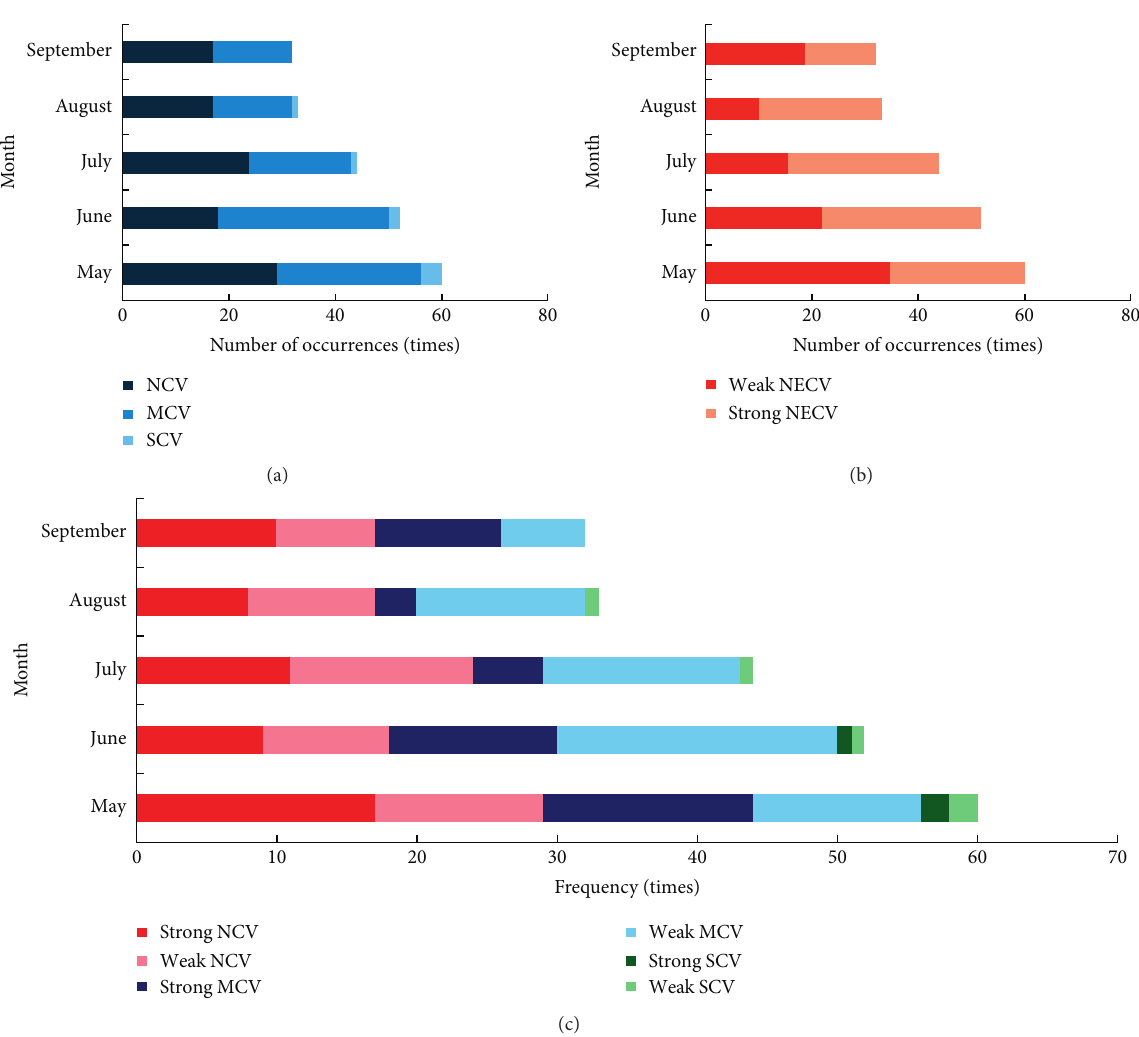
Figure 6: Monthly variations for the occurrence frequencies of NECVs with different types (unit: